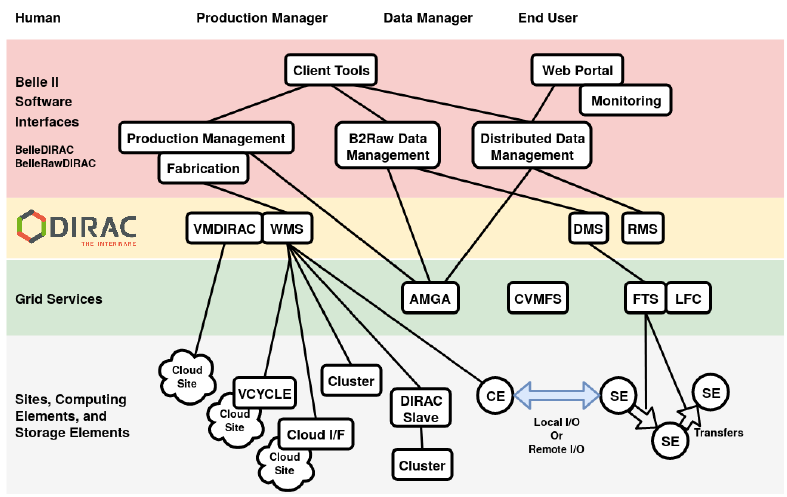
Figure 6. Distributed computing components used at the Belle II